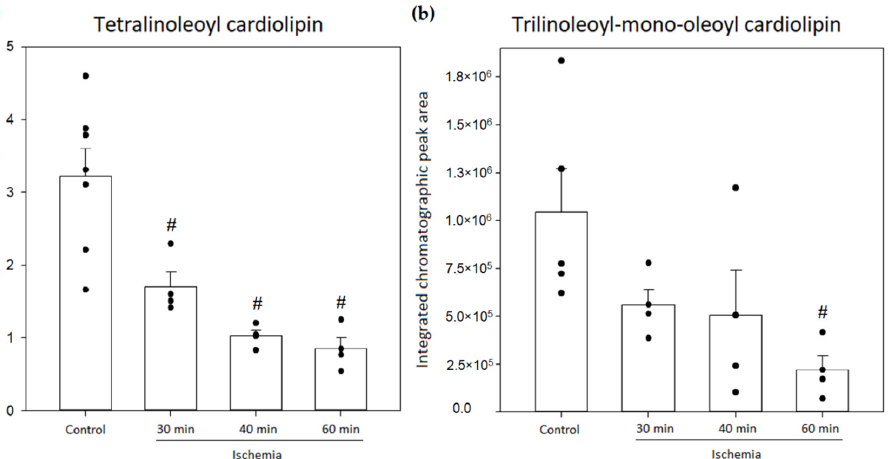
Figure 6. Changes in amounts of mitochondrial cardiolipin in the control group and after 30, 40 and 60 min of kidney ischemia. ( a ) Changes in the amounts of tetralinoleoyl cardiolipin ( n = 4–7); ( b ) changes in the relative amounts of trilinoleoyl-mono-oleoyl cardiolipin ( n = 4–5). (# p < 0.05 control vs. ischemia, dots represent values of each experiment, mean ± standard error).